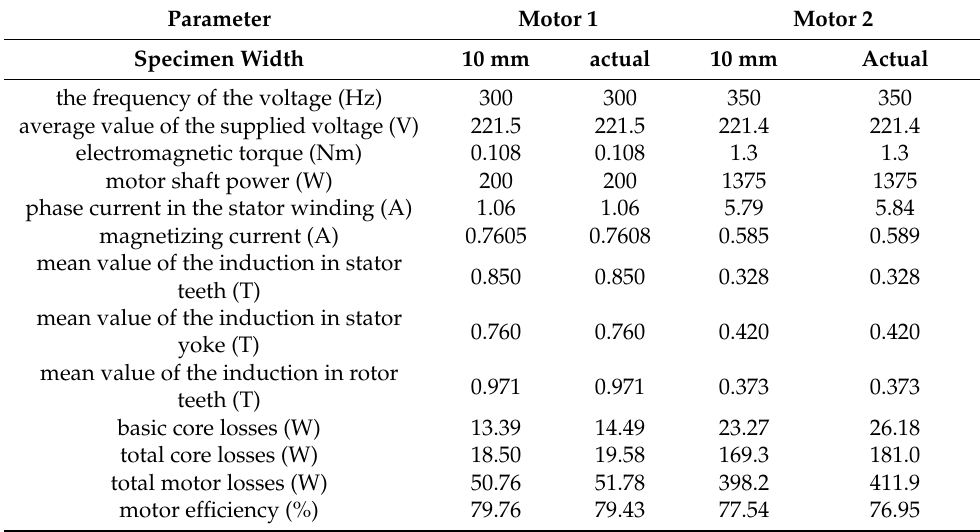
Table 2. Electromagnetic parameters of motors determined for the characteristics measured for a speci- men with a constant width, and specimen with a width corresponding to the cores’ actual